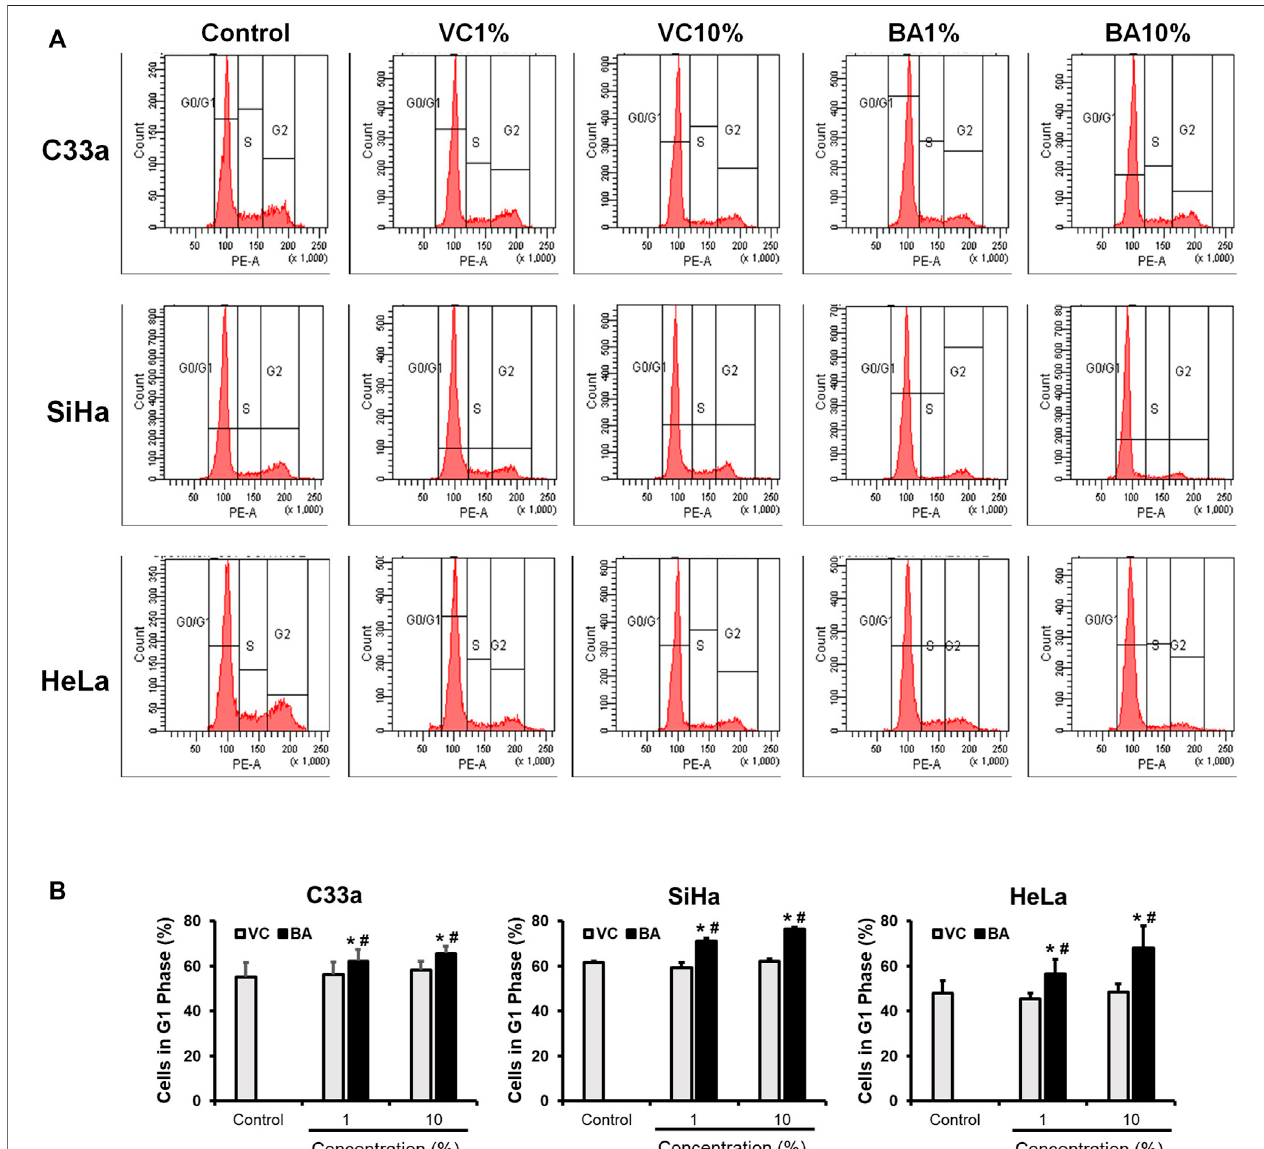
FIGURE 2 | Effect of BAMT on distribution of cervical cancer cells in different phases of the cell cycle. (A) Representative fl owcytometric analysis showing histograms of propidium iodide-stained nuclei from BAMT-treated CaCx cells. Cell were gated for G1, S and G2/M phases. (B) . Cumulative analysis of total cell population in G1 phase after treatment with BAMT or alcohol. Data represent mean ± SD with * p values ≤ 0.05 with respect to control. # p values ≤ 0.05 compared to cultures treated with corresponding vehicle control (VC).